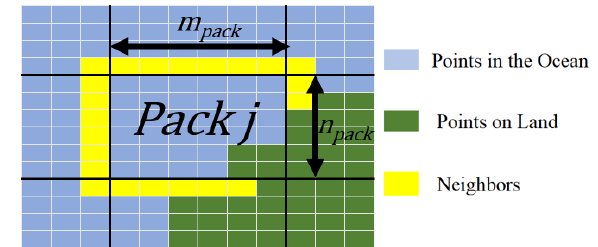
Figure 1. The various packs on a sample map. The points within a pack that are blue are the eligible points in the ocean that the pack’s designated reservoir computer will attempt to forecast. Points in green represent land, which are not eligible points and whose in- dices are ignored in the formation of the pack.